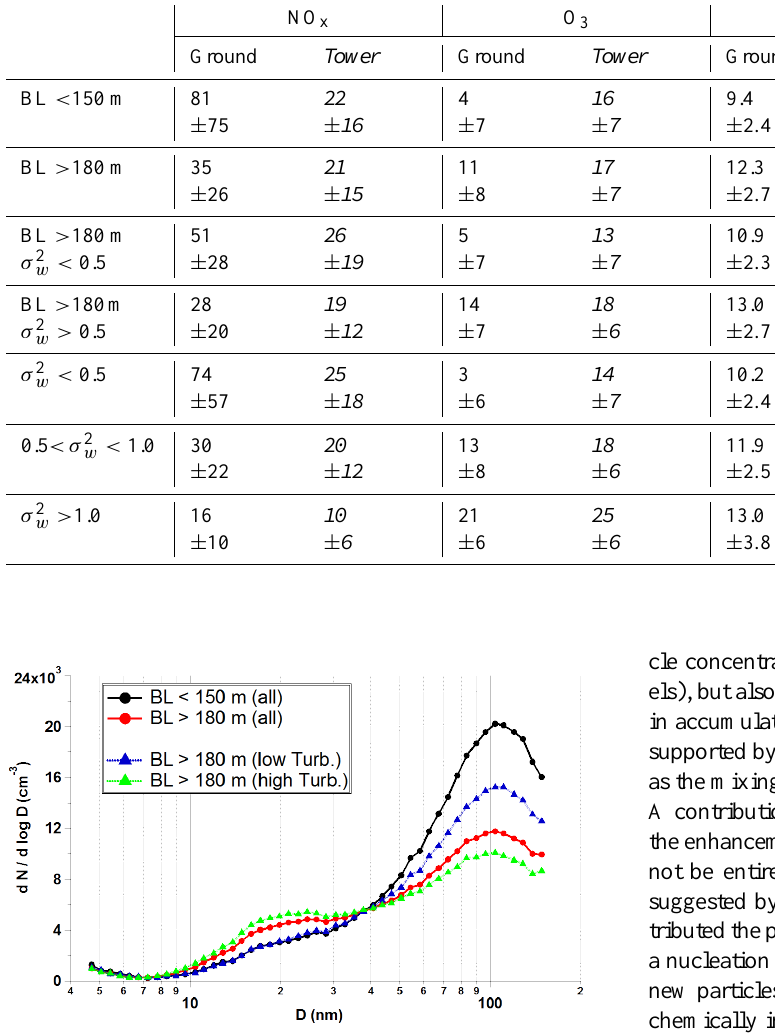
Table 3. Concentrations (mean ± s.d.; ppb) of NO x and O 3 at ground level (NK) and aloft on the BT Tower as a function of mixed layer depth (BL) and turbulence level (low is σ 2 w < 0.5m 2 s − 2 ; high is σ w > 0 . 5m 2 s − 2 ) . Units are in ppb for gas measurements, degrees Celsius for temperature (Temp) and % for Relative Humidity (RH).